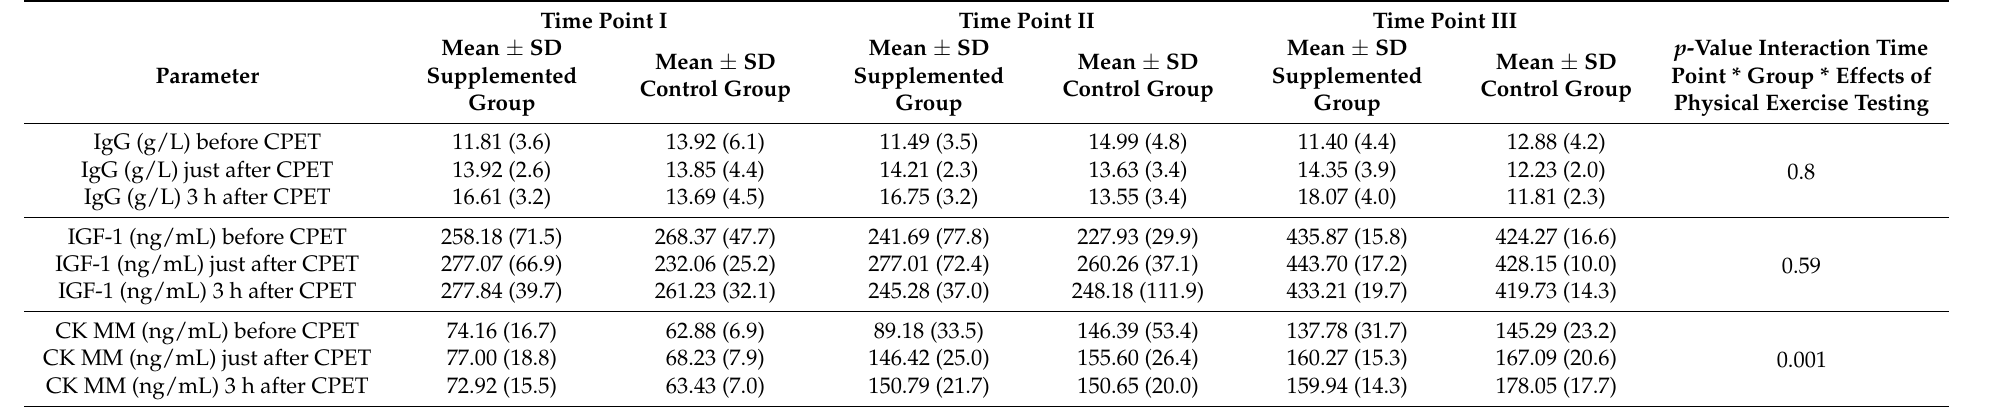
Table 4. Effects of supplementation on immune system function